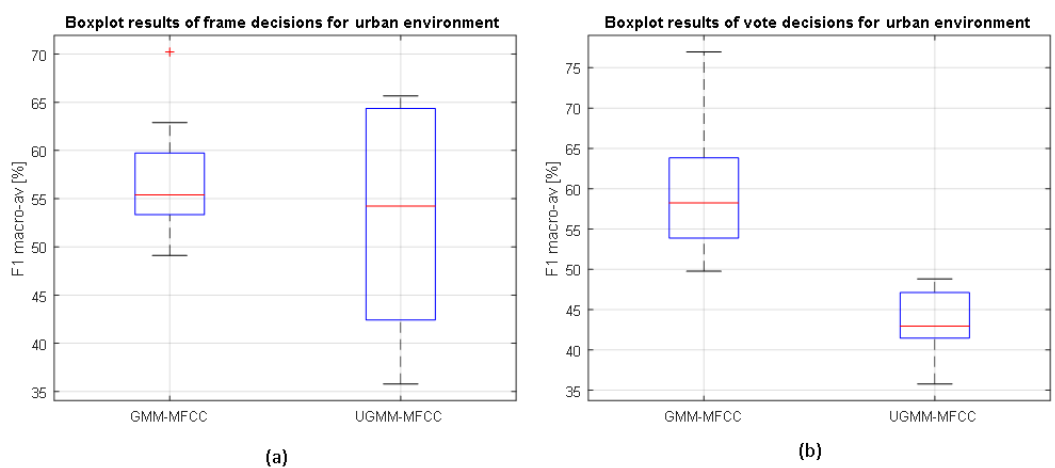
Figure 5. Boxplots of the classifiers’ performance at the ( a ) frame level and ( b ) high level on the urban environment considering the binary-based GMM and UGMM classifiers and MFCC features, as well as following a leave-one-out cross-validation